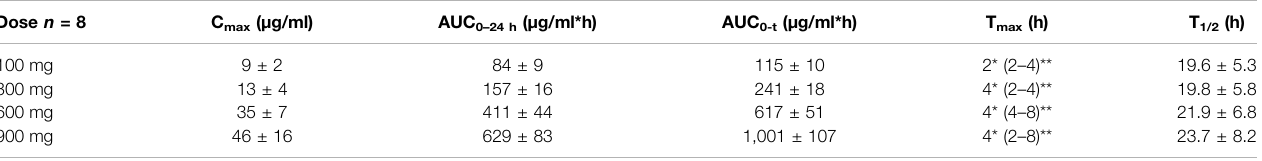
TABLE 5 | Summary of zapnometinib pharmacokinetic parameters for SAD study in healthy volunteers. Dose n = 8